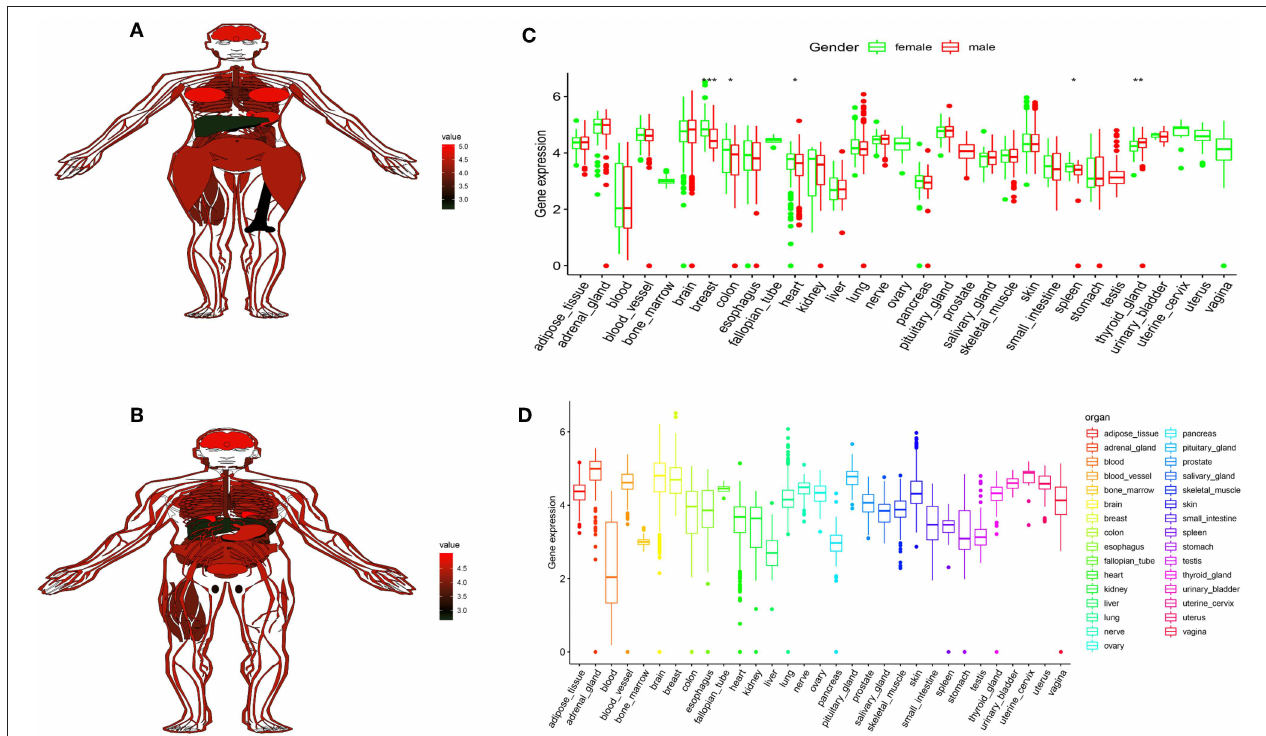
FIGURE 6 | FTO showed high expression in human tissues. (A,B) The map shows the expression levels of the FTO in the 31 solid organ tissues in female and male. (C) Histogram visualizing the differentially FTO in the 31 solid organ tissues in female and male. (D) Histogram visualizing the differentially FTO in the 31 solid organ tissues. * P < 0.05, ** P < 0.01, and *** P <